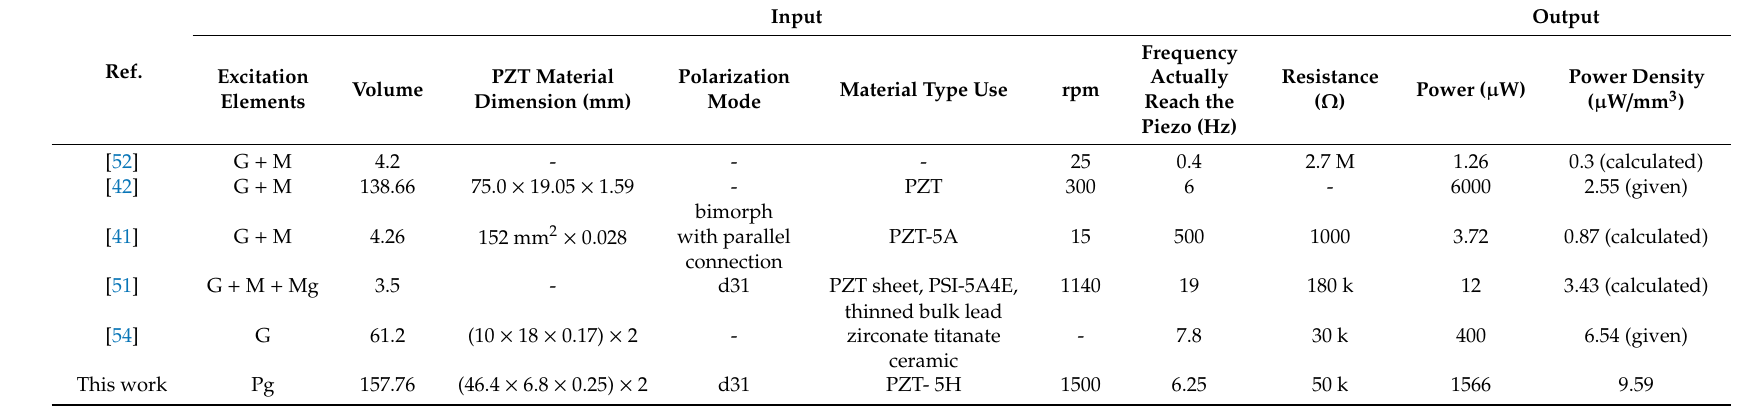
Table 5. Comparison with Previous Rotational PZT Energy Harvesting Studies That Used Gear with This